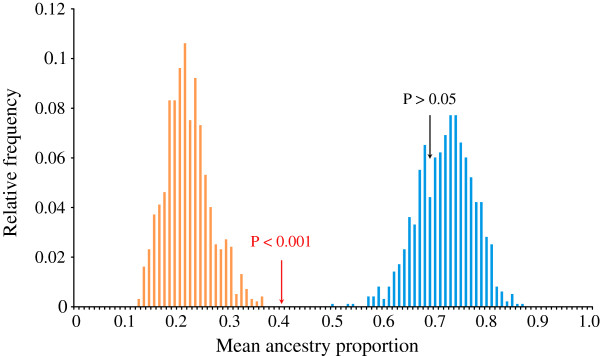
Suspected hybrids from Iceland are genetically intermediate compared to continental eels. In analogy to an urn model and in reference to the group of 16 suspected hybrid Icelandic eels, groups of 16 genotypes each were drawn 1000 times from either continental eel population with the mean ancestry proportion calculated for each draw. The permutation test illustrates bimodality, as expected under a two-species model with American eels (orange), and European eels (blue). The mean ancestry proportion of the suspected hybrid eel group is exactly intermediate (red pointer; Qsuspects = 0.40; P < 0.001), whereas the mean for Icelandic eels with European haplotypes is not significantly different from the European eel population (black pointer; Qmean = 0.65; P > 0.05).